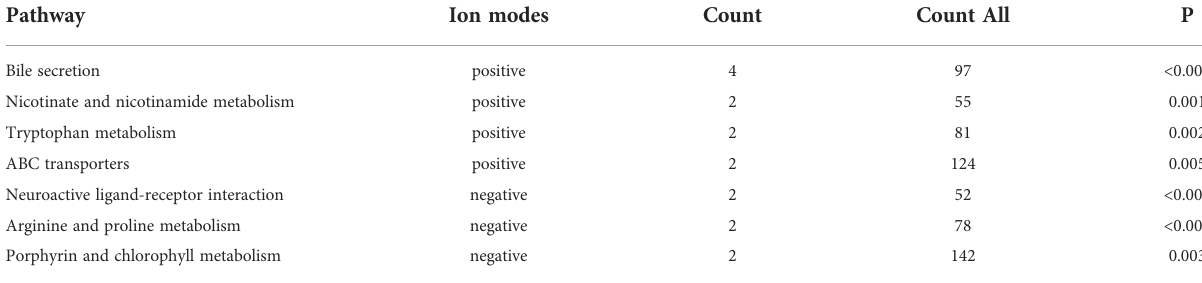
TABLE 4 Differential metabolite pathway